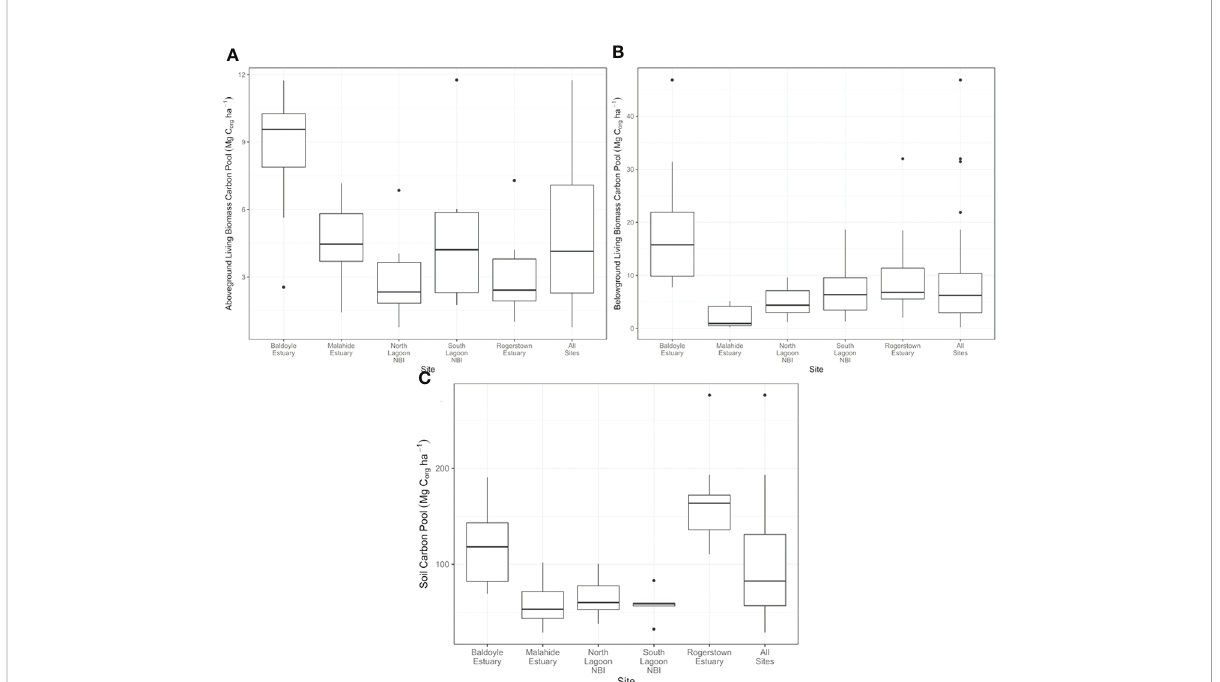
FIGURE 2 The carbon densities per hectare (Mg C org ha − 1) of each carbon pool and of each site (L-R: Baldoyle Estuary, Malahide Estuary,North Lagoon of North Bull Island, South Lagoon of North Bull Island, Rogerstown Estuary, and all sites combined) where (A) is the aboveground carbon pool, (B) is the belowground carbon pool, and (C) is the soil carbon